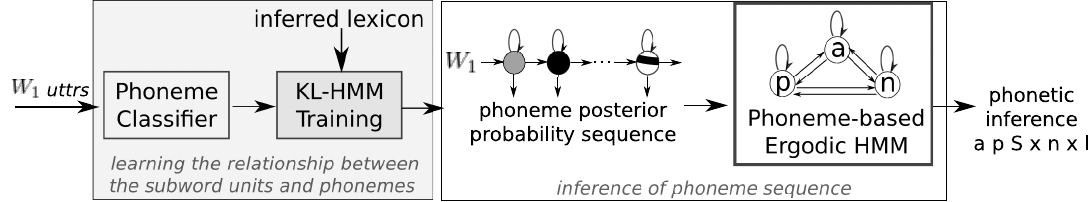
Figure 2. Illustration of the phoneme inference according to the derived subword units.